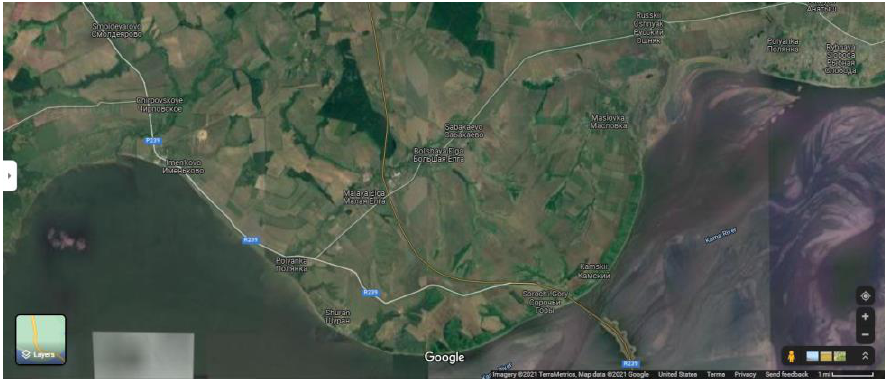
Figure 2. A closer look of the farm’s location.